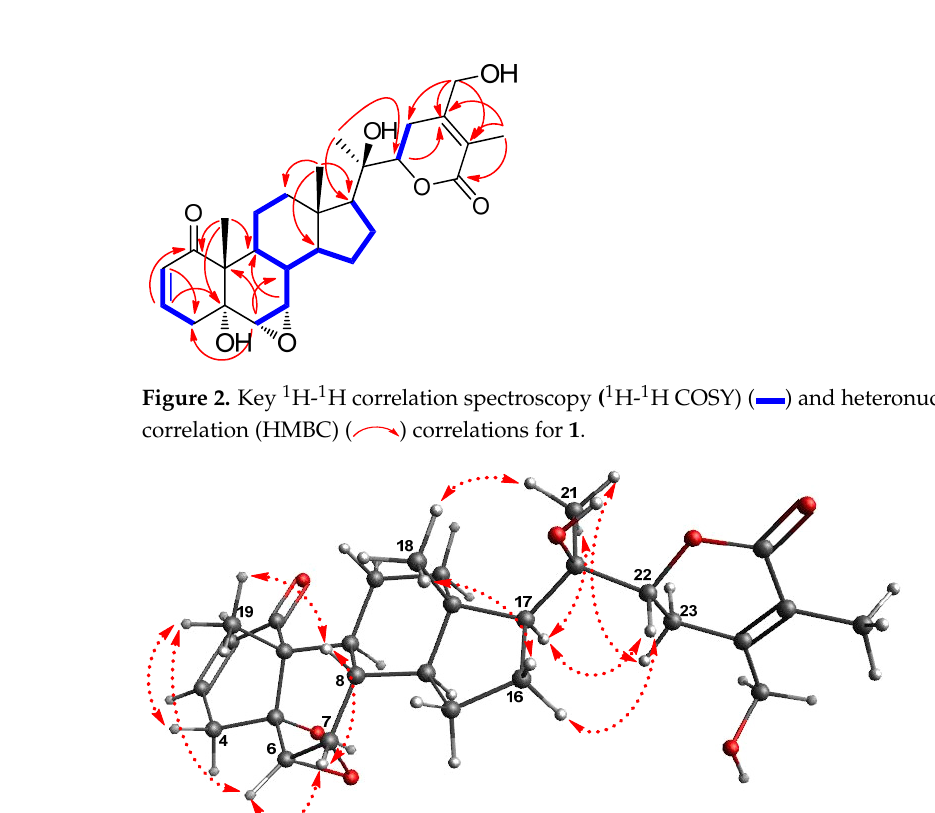
Figure 3. Key rotating-frame Overhauser enhancement spectroscopy (ROESY) correlations for 1 .